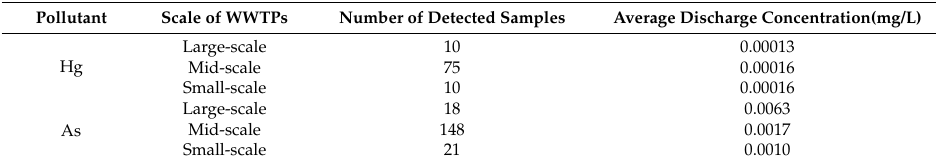
Table 5. Discharge concentrations of Hg and As for different scales of WWTPs.